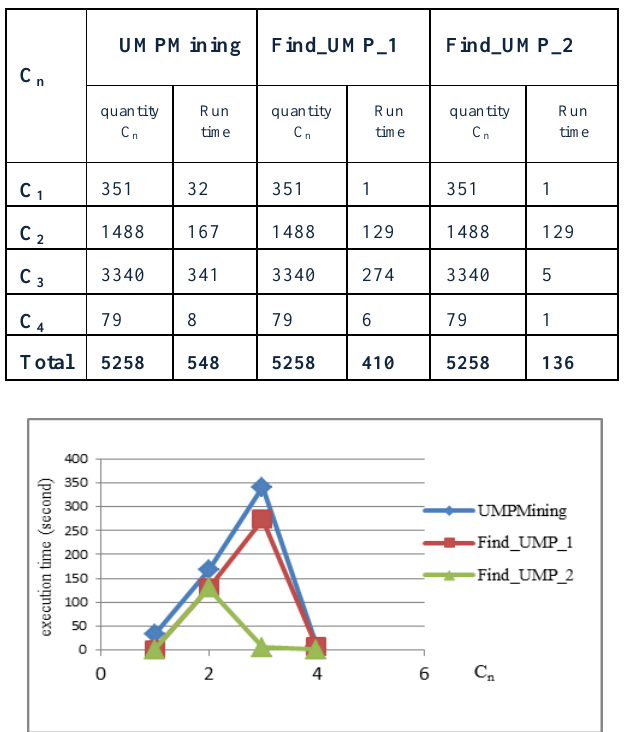
Table 6. The results of three algorithms